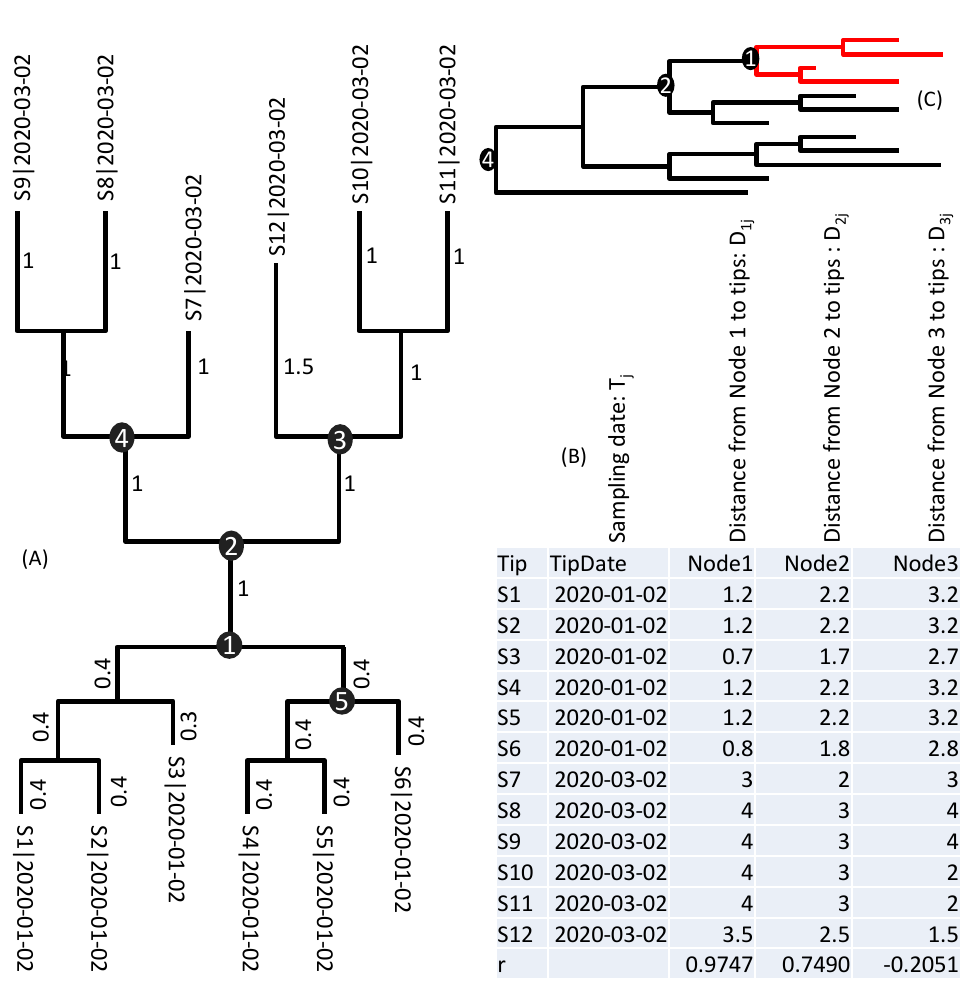
Figure 1. Rationale for identifying which internal node is closest to the true root: ( A ) a tree with 12 tips (S1 to S12) whose sampling dates are appended to sequence names. Branch lengths are shown next to branches, and five internal nodes numbered; ( B ) node-to-tip distances and sampling date between internal Nodes 1, 2, and 3 to the 12 tips. The best internal node is Node 1 with the highest r, but the best rooting position is along the branch between Nodes 1 and 5, at a distance of 0.087117 from Node 1; ( C ) samples including descendants of Node1 can only date their MRCA at Node 1. Only when the most ancient lineage is sampled can we date the MRCA at node 4.